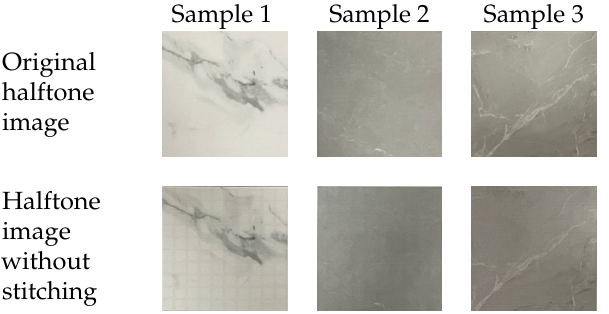
Figure 9. A comparison of halftone image results without